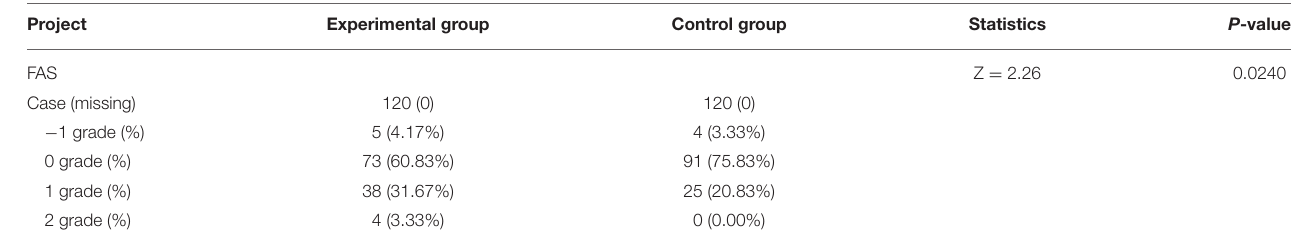
TABLE 8 | Changes in the severity of angina pectoris in the two